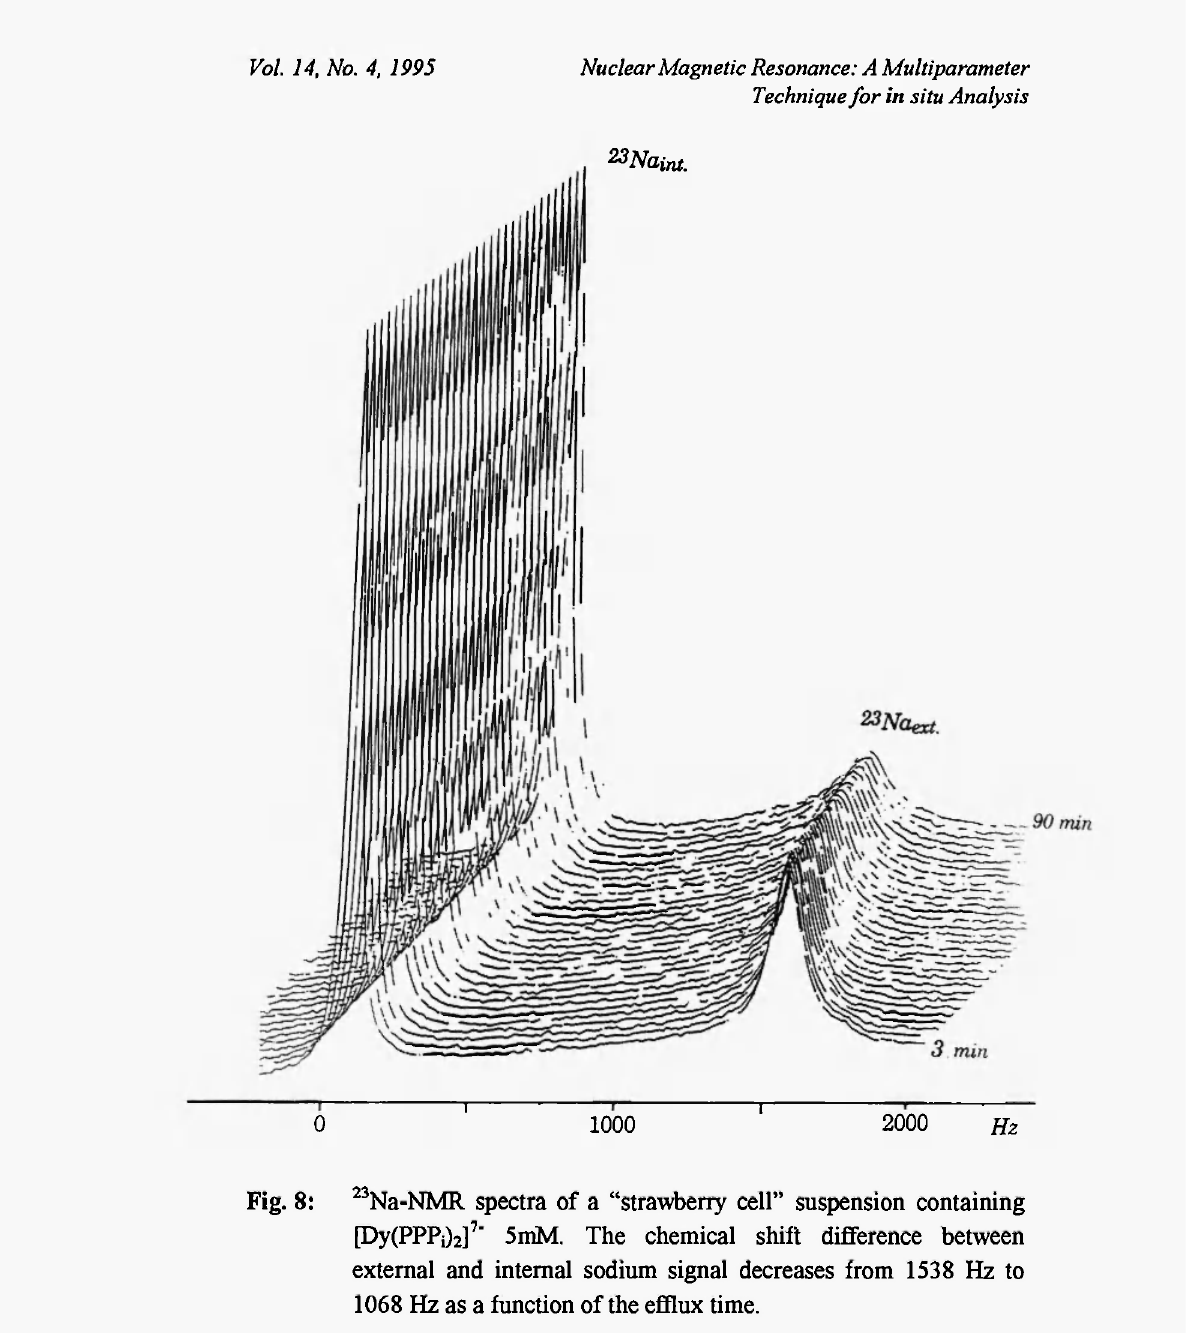
Fig. 8: 23 Na-NMR spectra of a "strawbeny cell" suspension containing Py(PPPi) ] 7 " 5mM. The chemical shift difference between 2 external and internal sodium signal decreases from 1538 Hz to 1068 Hz as a function of the efflux